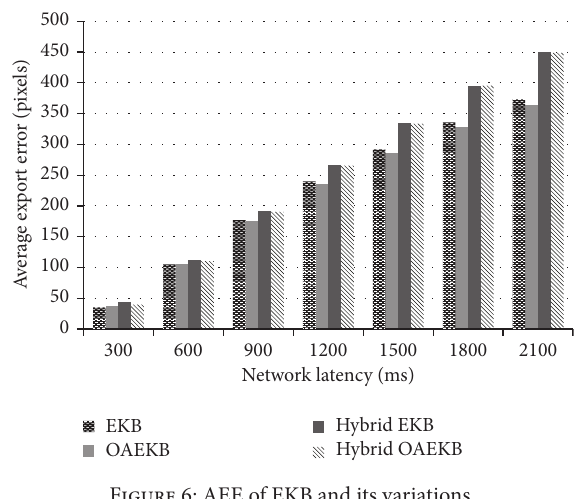
Figure 6: AEE of EKB and its variations. Table 3: AEE of EKB and its variations.